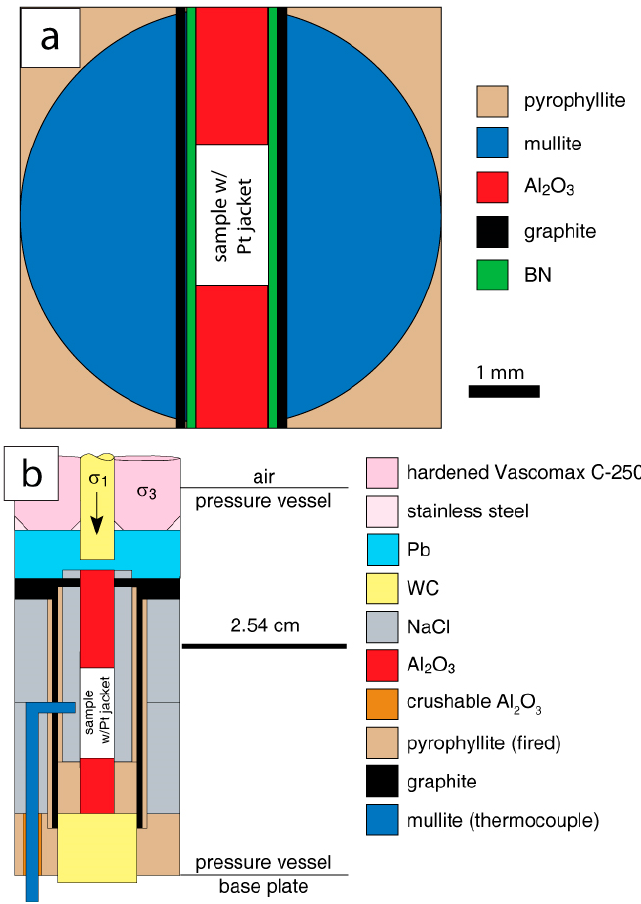
Figure 1. A modified Durham-type assembly [40] was used in all experiments performed using the D-DIA ( a ). A solid salt assembly was used in all experiments performed in the Griggs apparatus ( b ).